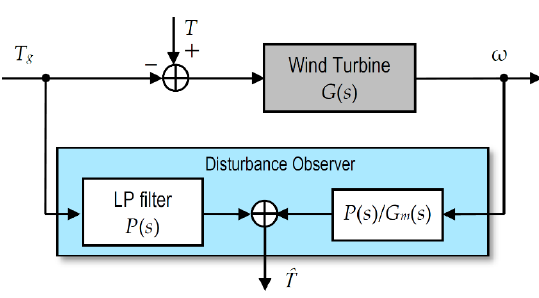
Figure 7. Transfer function based disturbance observer.